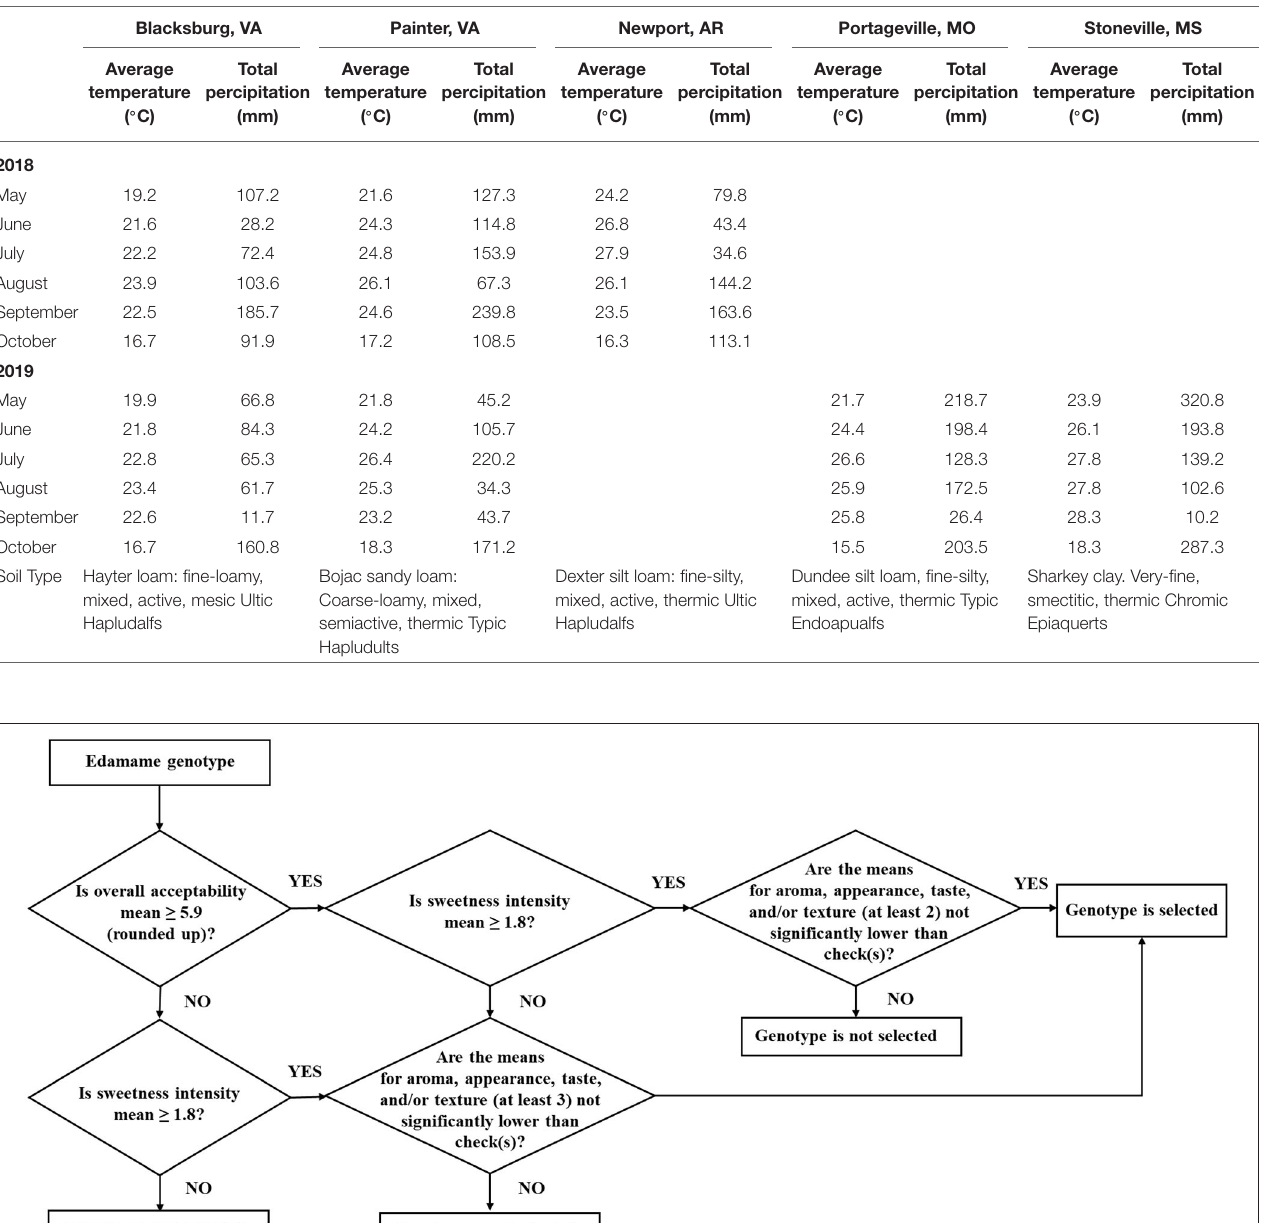
TABLE 2 | Environmental characteristics of growing locations.